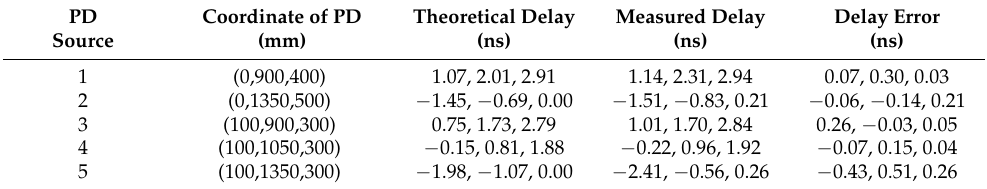
Table 7. Theoretical time delay, measured time delay, and time delay errors of the five PD